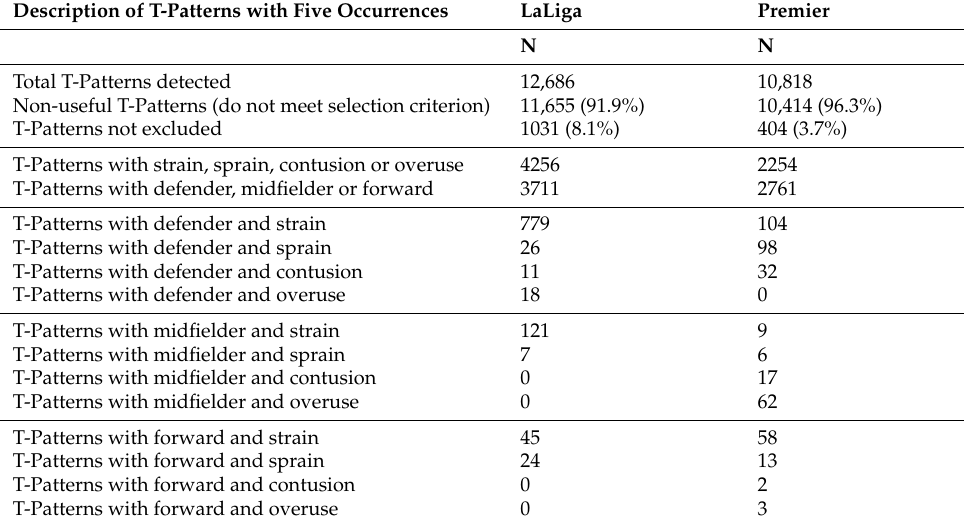
Table 4. Analysis of the selective search for T-Patterns.